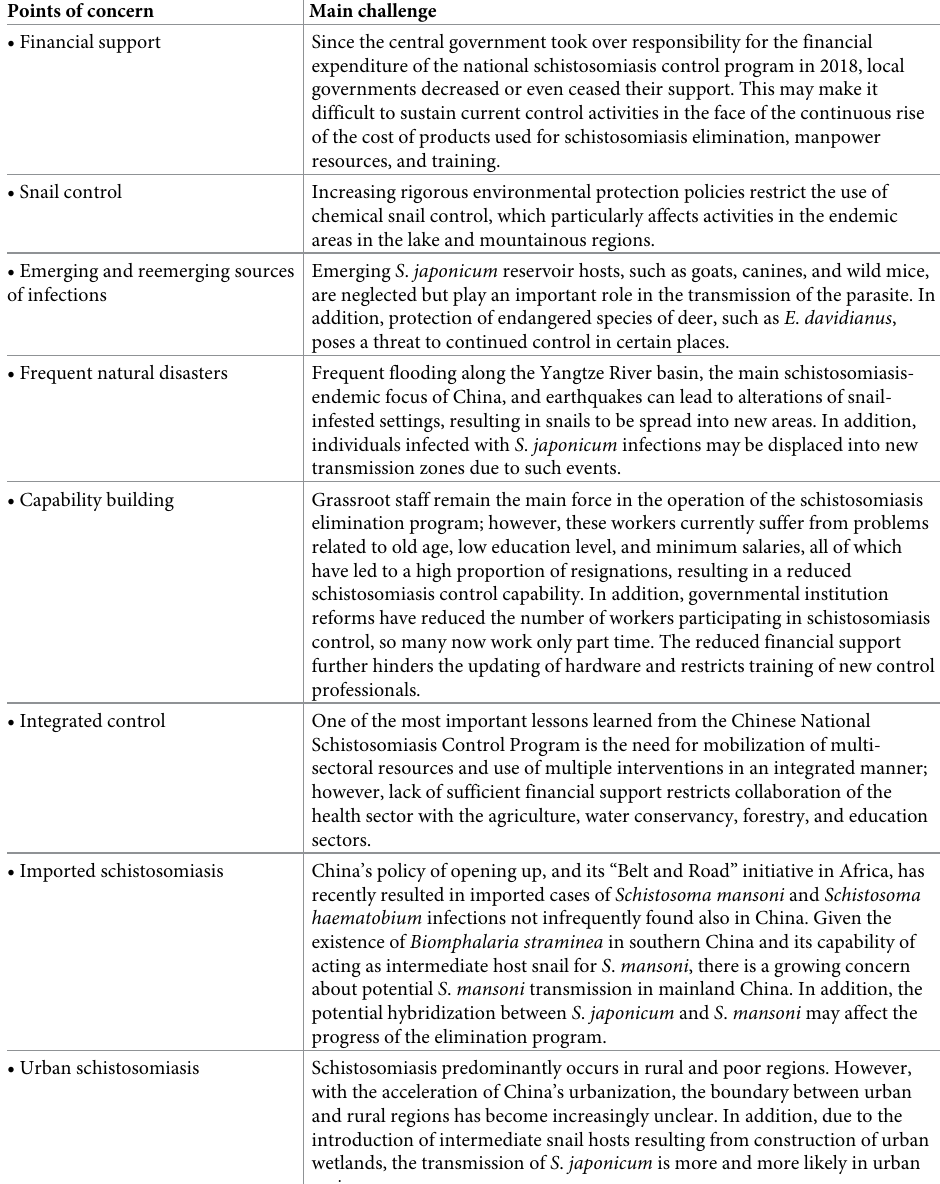
Table 2. Potential challenges for elimination of schistosomiasis in